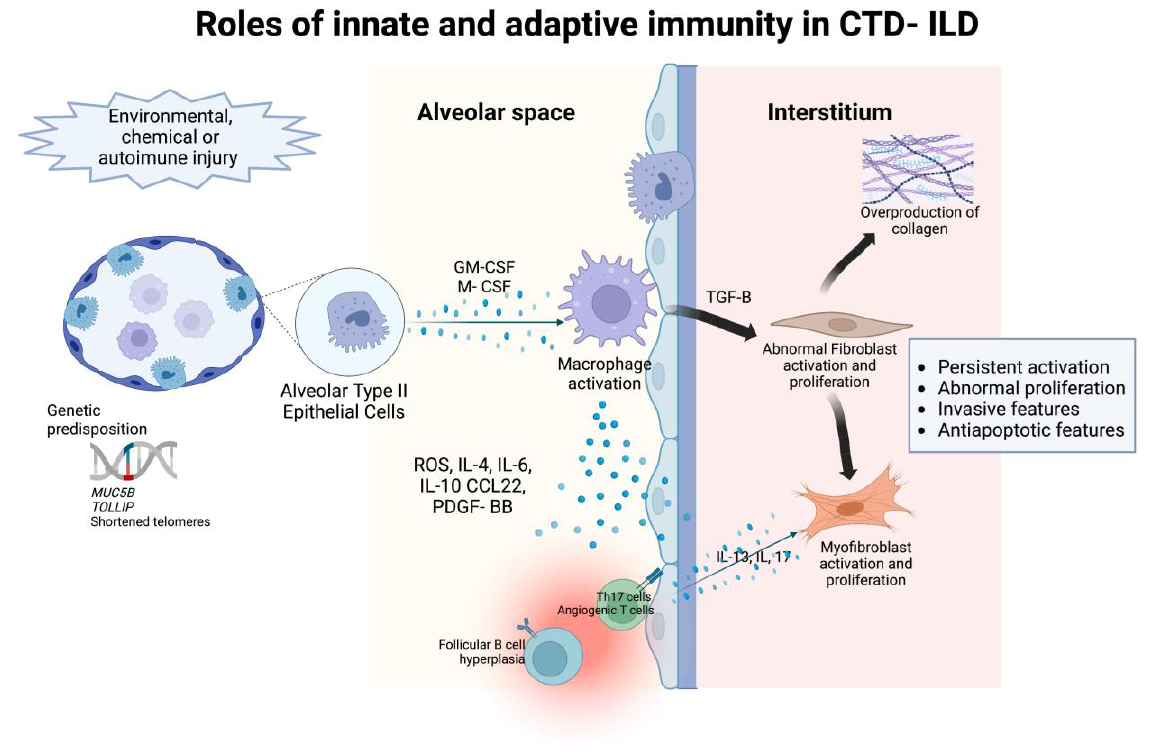
Figure 1. The roles of innate and adaptive immunity in the pathogenesis of intersitial abnormalities in connective tissue disease- associated interstitial lung disease.